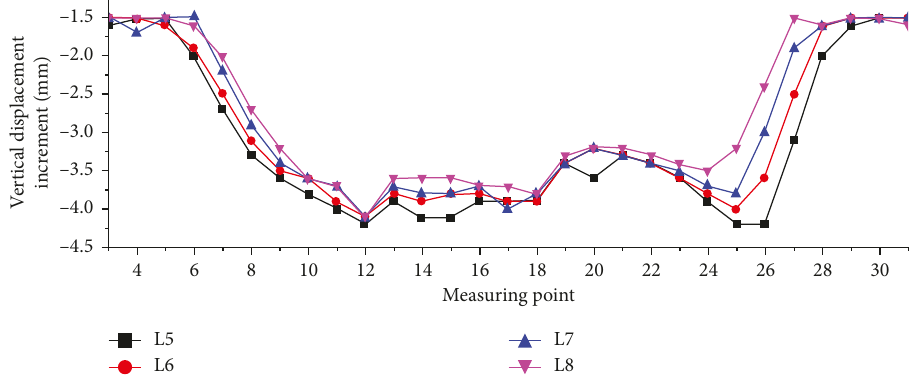
Figure 15: Vertical displacement of line L5–L8 after instability of coal